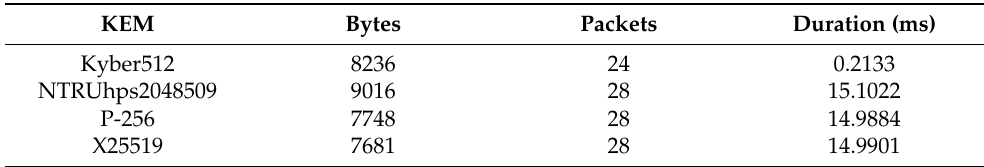
Table 13. Summary of the bytes, packets and the duration of the connection for each test. We present the mean value for each